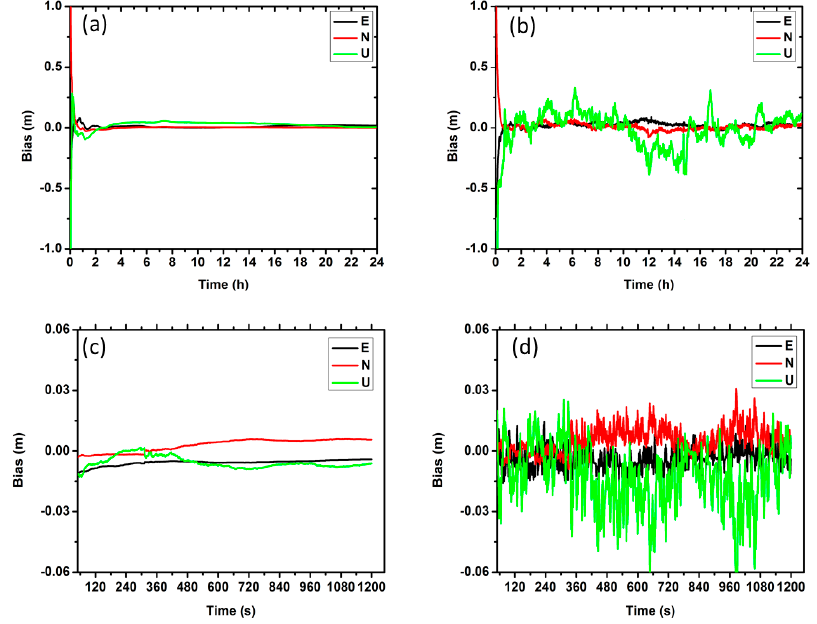
Figure 3. The positioning errors of the BDS PPP/URTK (( a , b ) represents the static and dynamic results by PPP mode; and ( c , d ) represents the static and dynamic results by URTK mode). Table 3. Statistics of the positioning accuracy.